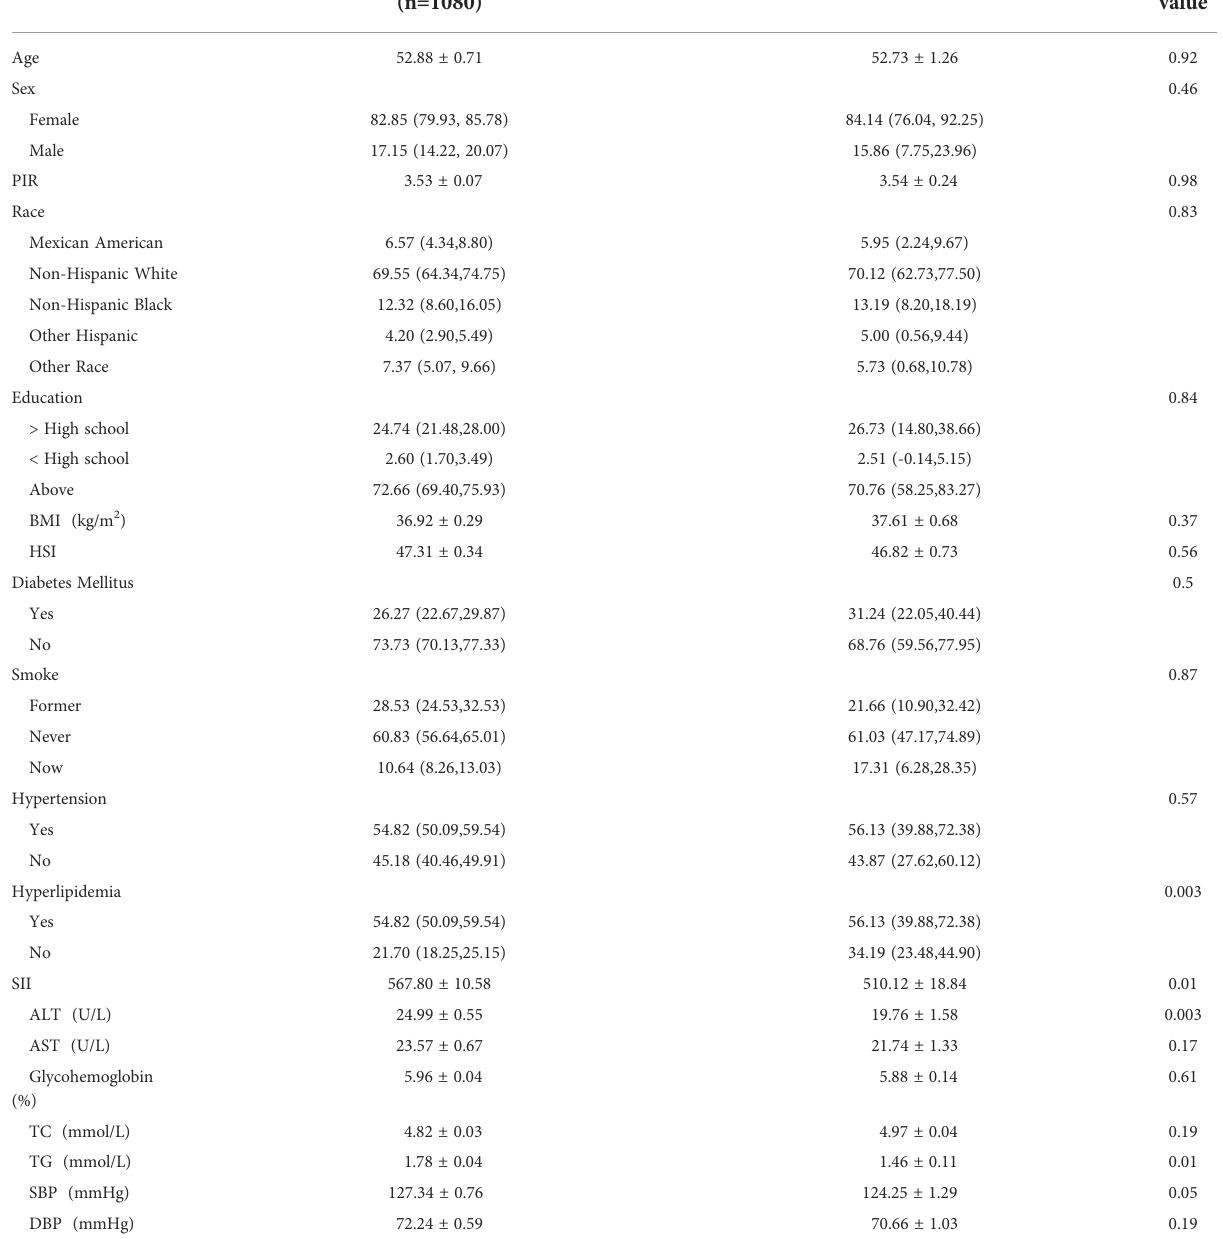
TABLE 3 Basic characteristics of participants with hepatic steatosis with/without bariatric surgery after PSM Analysis in the NHANES 2015 – 2018.